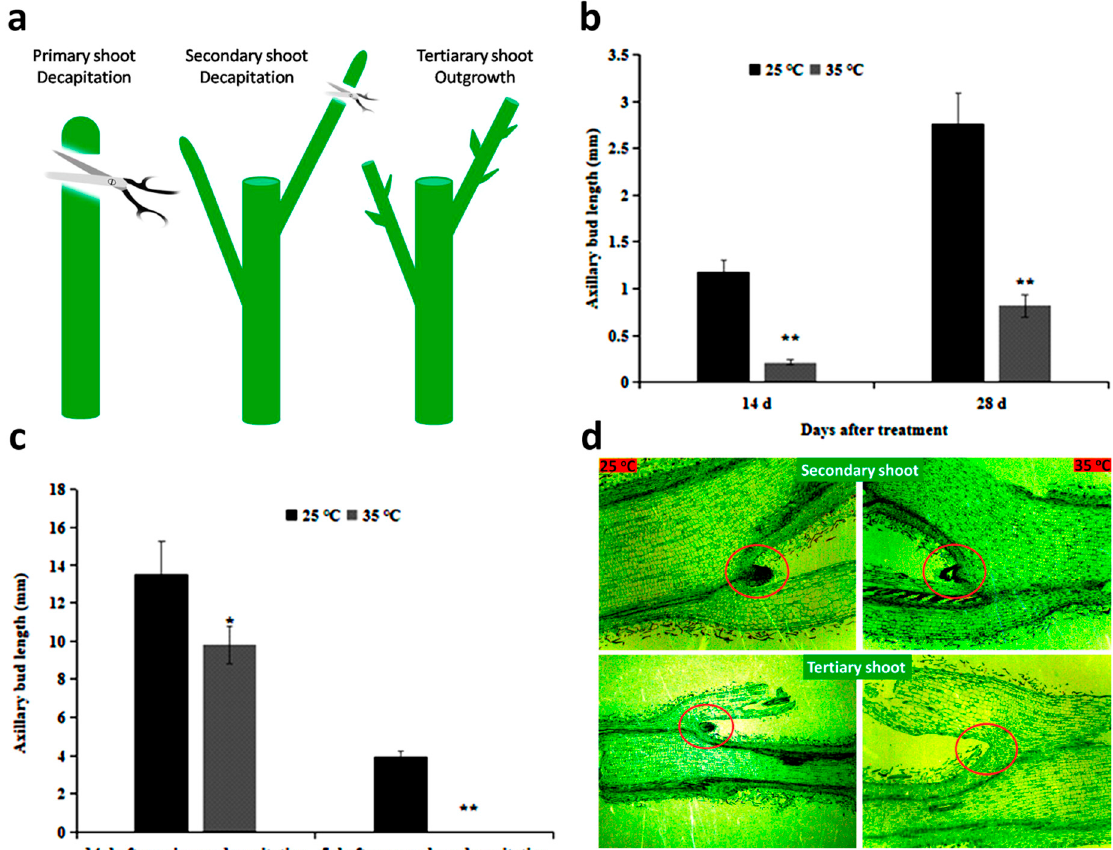
Figure 1. Axillary bud growth status in contrasting temperatures. ( a ) Models of decapitation experiments. Decapitation means removing upper 3 cm portion of main shoot including shoot apex of plants. The first decapitation performed on the un ‐ decapitated plants was regarded as primary decapitation and the axillary buds/shoots that emerged at the first axil after primary decapitation were regarded as secondary buds/shoots. Decapitation that was done on the newly formed first axillary shoots after primary decapitation was regarded as secondary decapitation. Axillary buds/shoots formed after secondary decapitation were regarded as tertiary buds/shoots; ( b ) The length of axillary buds under normal (25 °C) and high temperature (35 °C) treatment without decapitation; ( c ) The length of axillary buds under normal (25 °C) and high temperature (35 °C) treatment with decapitation; ( d ) Paraffin slicing micro ‐ observation of axillary buds after primary decapitation and secondary decapitation. The red circle position represents the axillary bud in first axil position. Significance is shown at * p < 0.05 and ** p < 0.01 level.